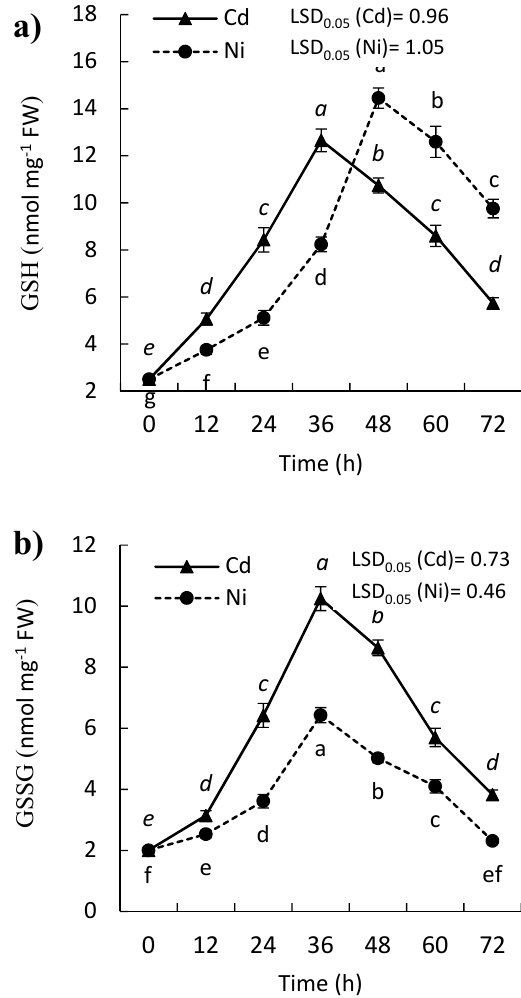
Figure 2. E ff ect of Cd and Ni on the amount of ( a ) reduced (GSH) and ( b ) oxidized glutathione (GSSG) in the leaves of P. sativum with time. Di ff erent letters per each line mean a significant di ff erence ( p ≤ 0.05 ). Values are average of means ( n = 6 ) and bars represent the standard error. LSD 0.05 is the least significant di ff erence at the probability level of 0.05.